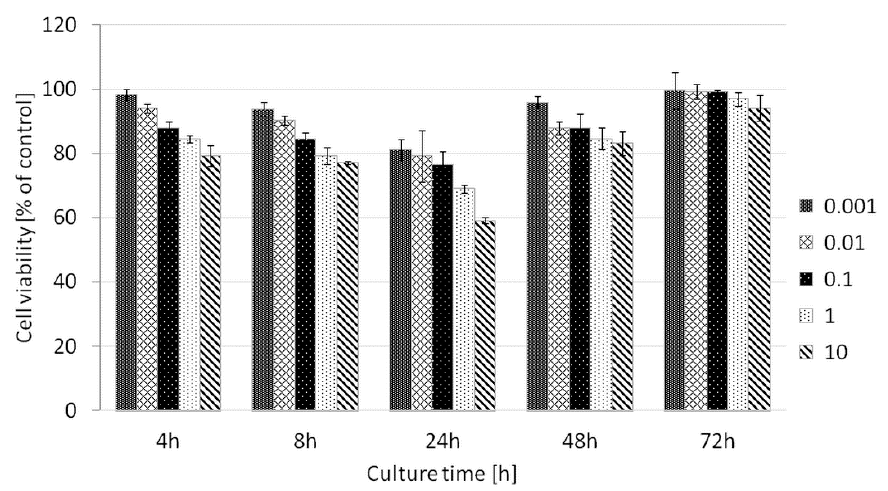
Figure 14. The cytotoxicity assay of the tested polymer (P(iPrOx-MOx-EI)1 at increasing concentrations (given in mg/mL). The assay was performed with HT-1080 cells. The results are shown as a percentage of the control, where untreated cells constituted 100%.